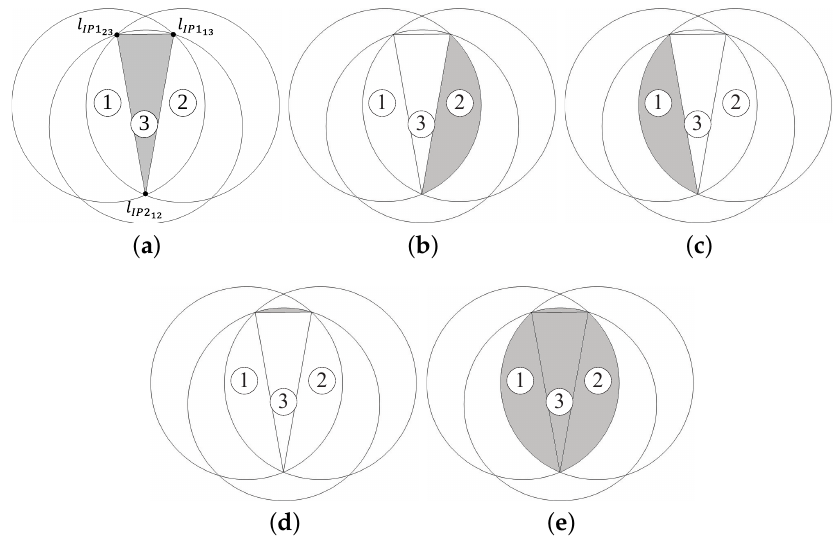
Figure 10. An intersection area within the transmission range of three nodes. ( a ) S 1 ; ( b ) S 2 ; ( c ) S 3 ; ( d ) S 4 ; ( e ) IA 123 .